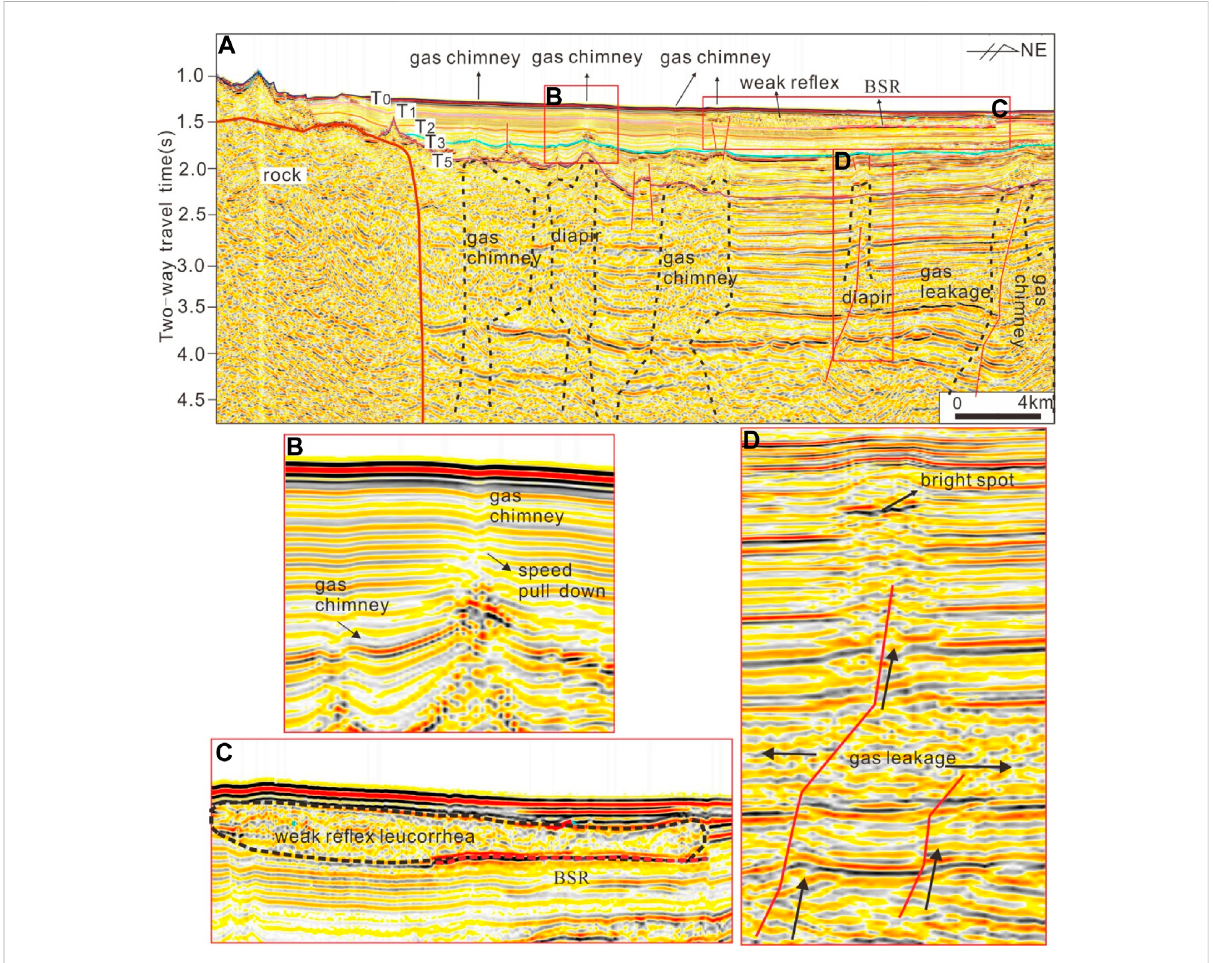
FIGURE 7 Schematic diagram of seismic pro fi le of mud diapir and gas chimney at the edge of the platform (B) . (C) and (D) are magni fi ed views of corresponding parts in (A)